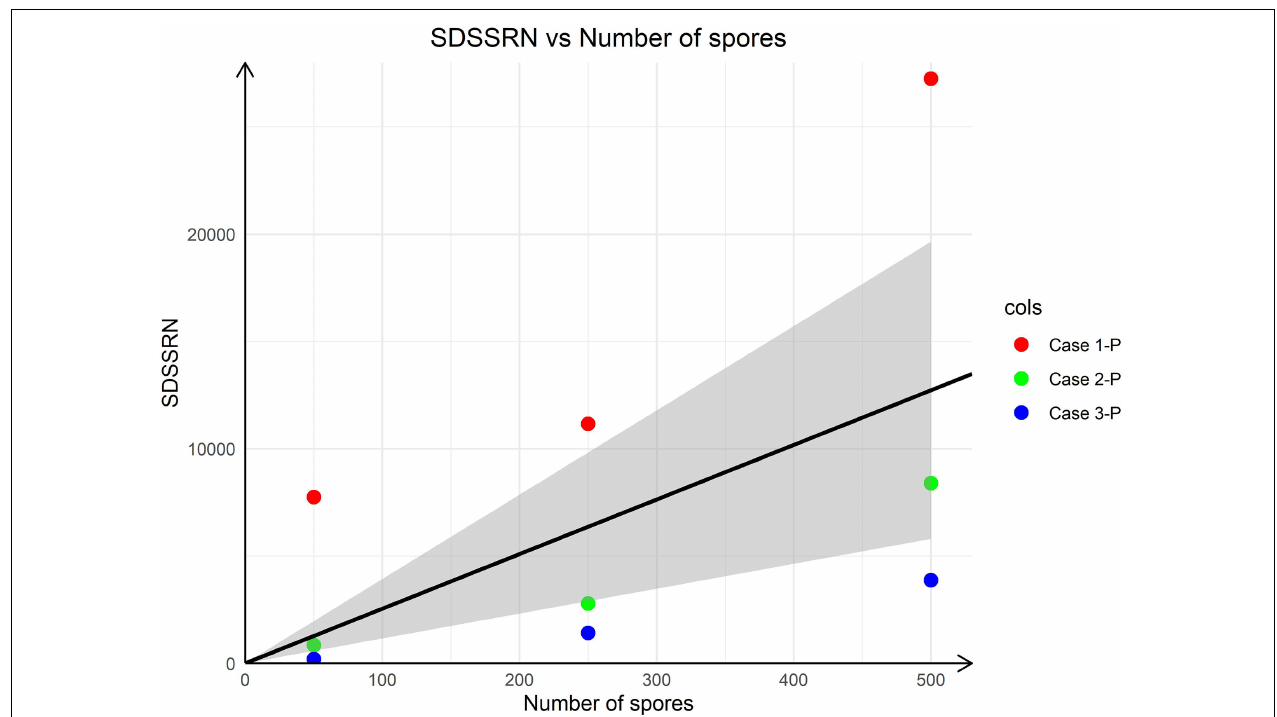
FIGURE 2 | Linear regression of SDSSRN versus the number of spores added. The linear regression has the function SDSSRN = 25.45 × (number of spores); the grey area corresponds to the 95% confidence level.